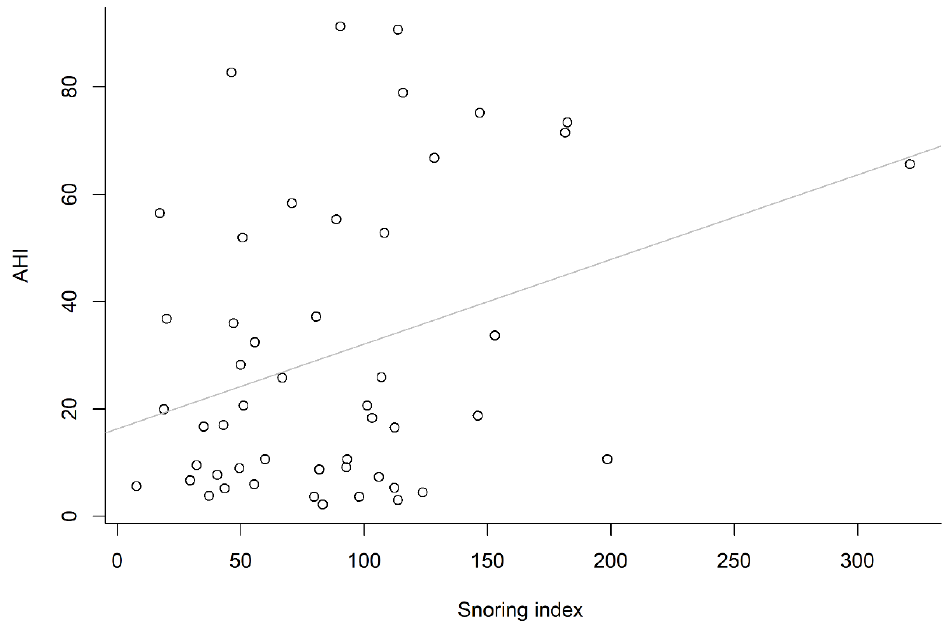
Figure 3. Positive correlation between snoring index and apnea–hypopnea index.